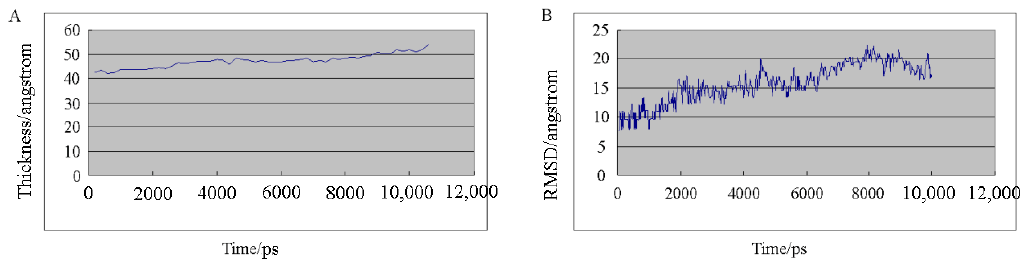
Figure 4. The simulation analysis results of DPPC biofilms: ( A ) Thickness; ( B ) RMSD .